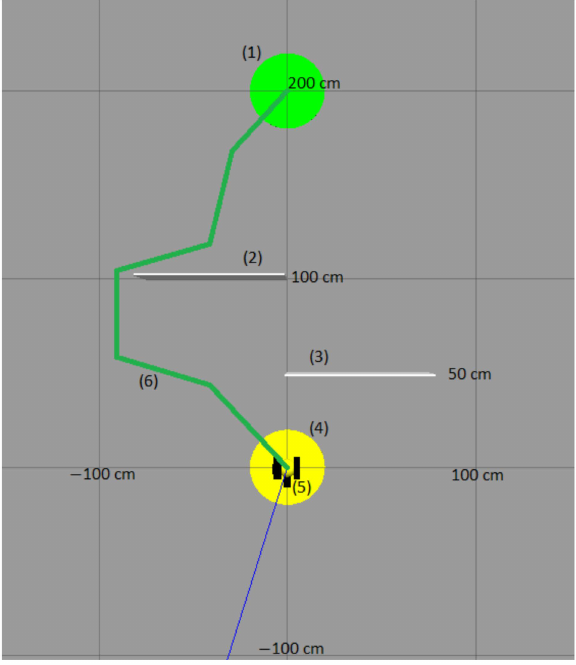
Figure 13. Trajectory in simulated scenario with two obstacles: (1) goal, (2,3) obstacles, (4) home, (5) robot, and (6) trajectory.